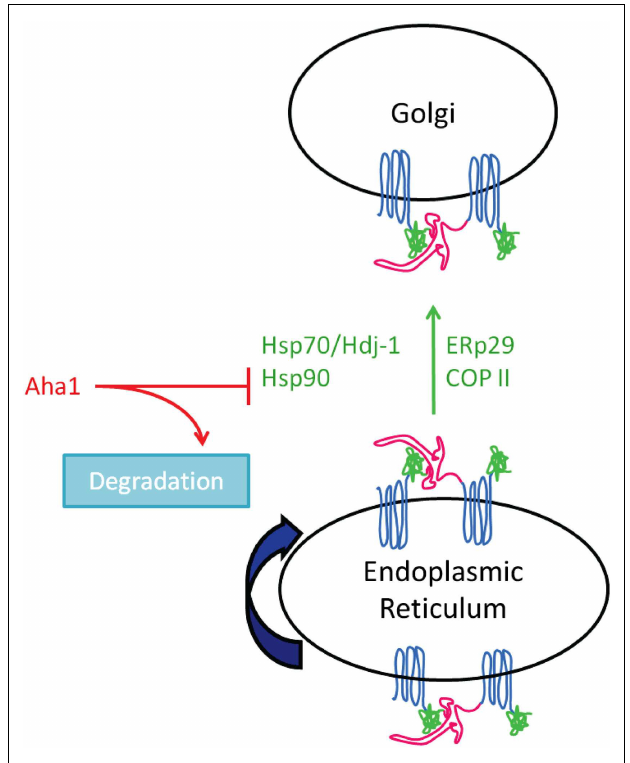
FIGURE 2 | Chaperone proteins implicated in ∆ F50S-CFTR biogenesis and